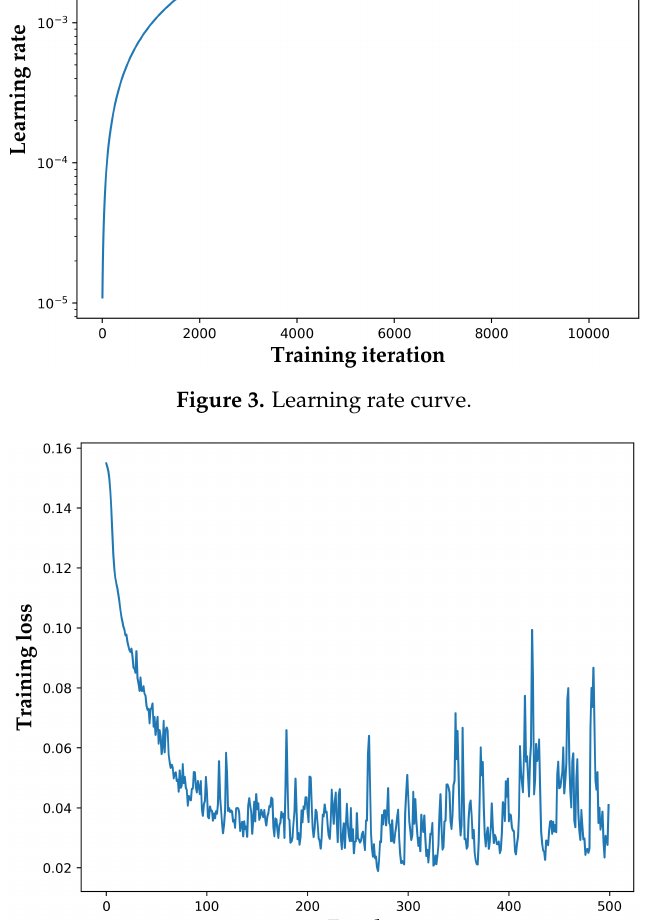
Figure 4. Relationship between network loss and training epoch.